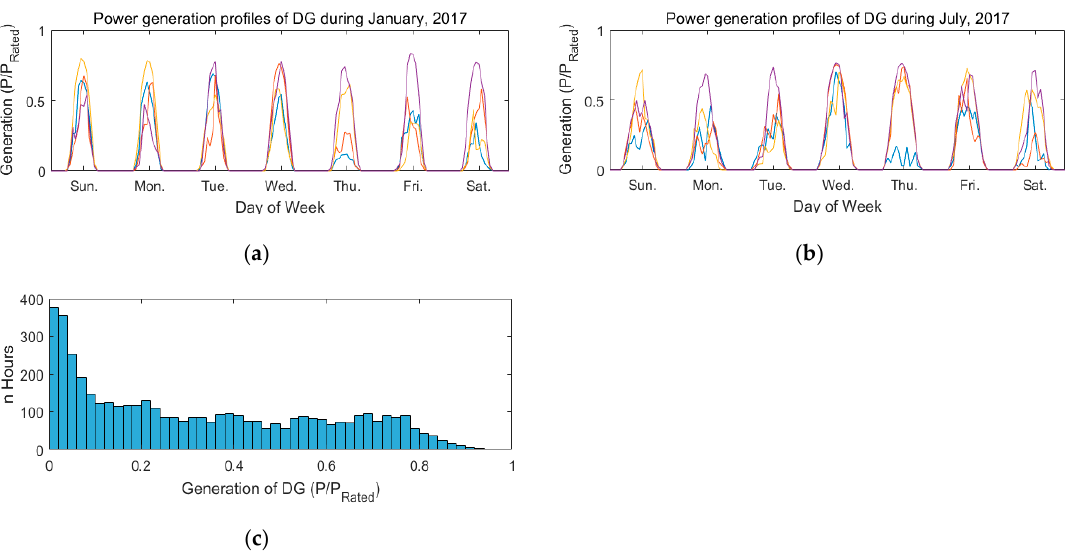
Figure 10. Measured power generation profiles in 1 ‐ hour averages during; ( a ) January, 2017 and ( b ) and ( c ) histogram of hours of measured power generation at Yeongam-gun, Jeollanam-do, Republic July, 2017; and ( c ) histogram of hours of measured power generation at Yeongam ‐ gun, Jeollanam ‐ do, Republic of Korea for 2017.